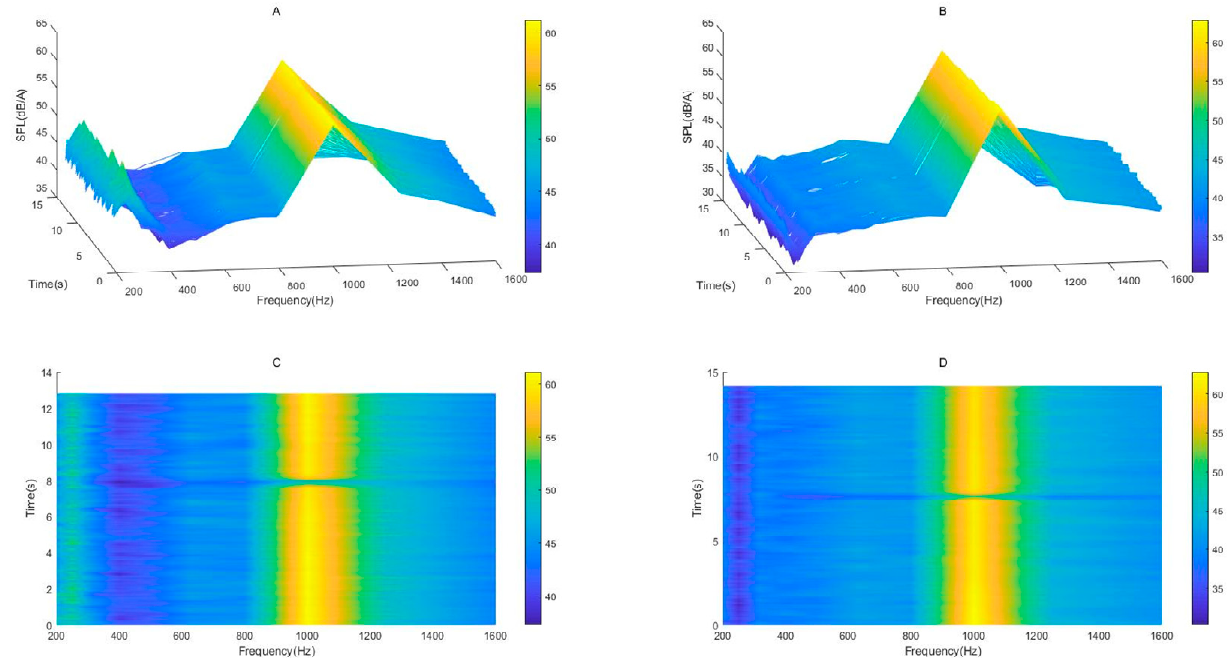
Figure 14. ( A ) Change in SPL and time within 200 to 1600 Hz before noise reduction, ( B ) change in SPL and time within 200 to 1600 Hz after noise reduction, ( C ) time frequency (200–1600 Hz) diagram before noise reduction, ( D ) time frequency (200–1600 Hz) diagram after noise reduction.